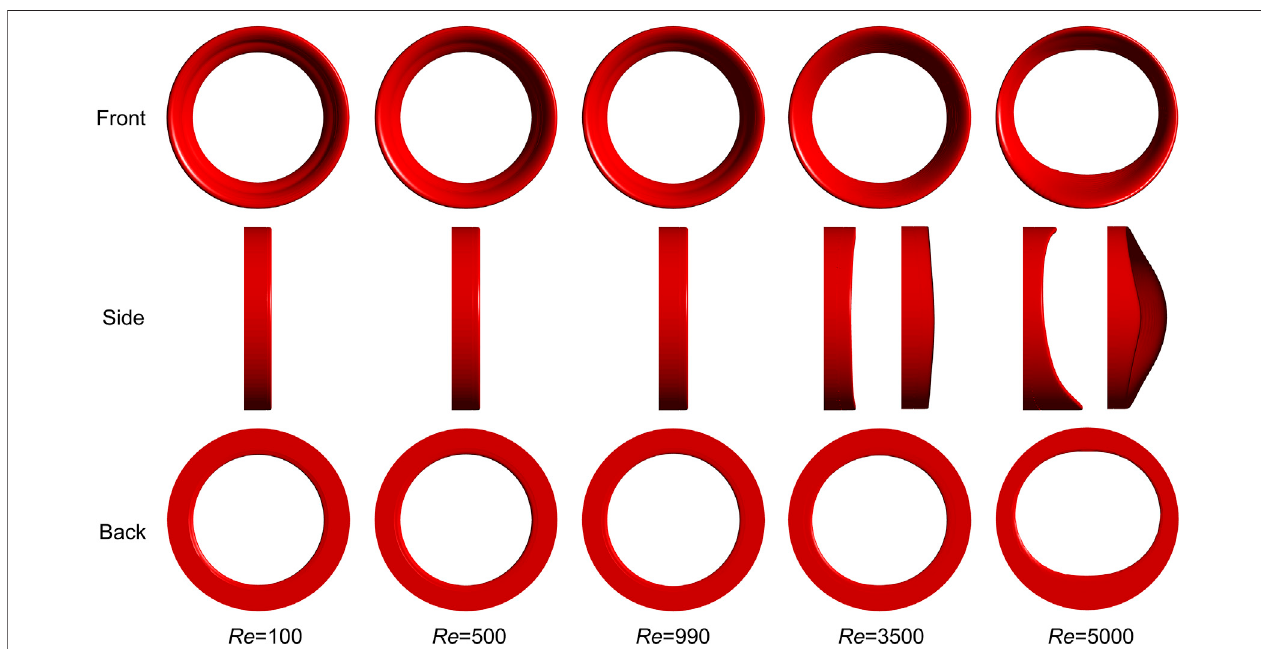
FIGURE 6 | Final thrombus shape in FDA benchmark nozzle. Thrombus volume is the same at different Reynolds numbers. There is no signi fi cant difference betweenthethrombusshapespredicted bythelaminarmodelandtheannularthrombusiscentrosymmetric.However,thethrombusbecomesonlyaxisymmetricwhen turbulence is present. Three rows indicate three different views. Two side views are used to show the thrombus shapes for Re = 3,500 and 5,000.